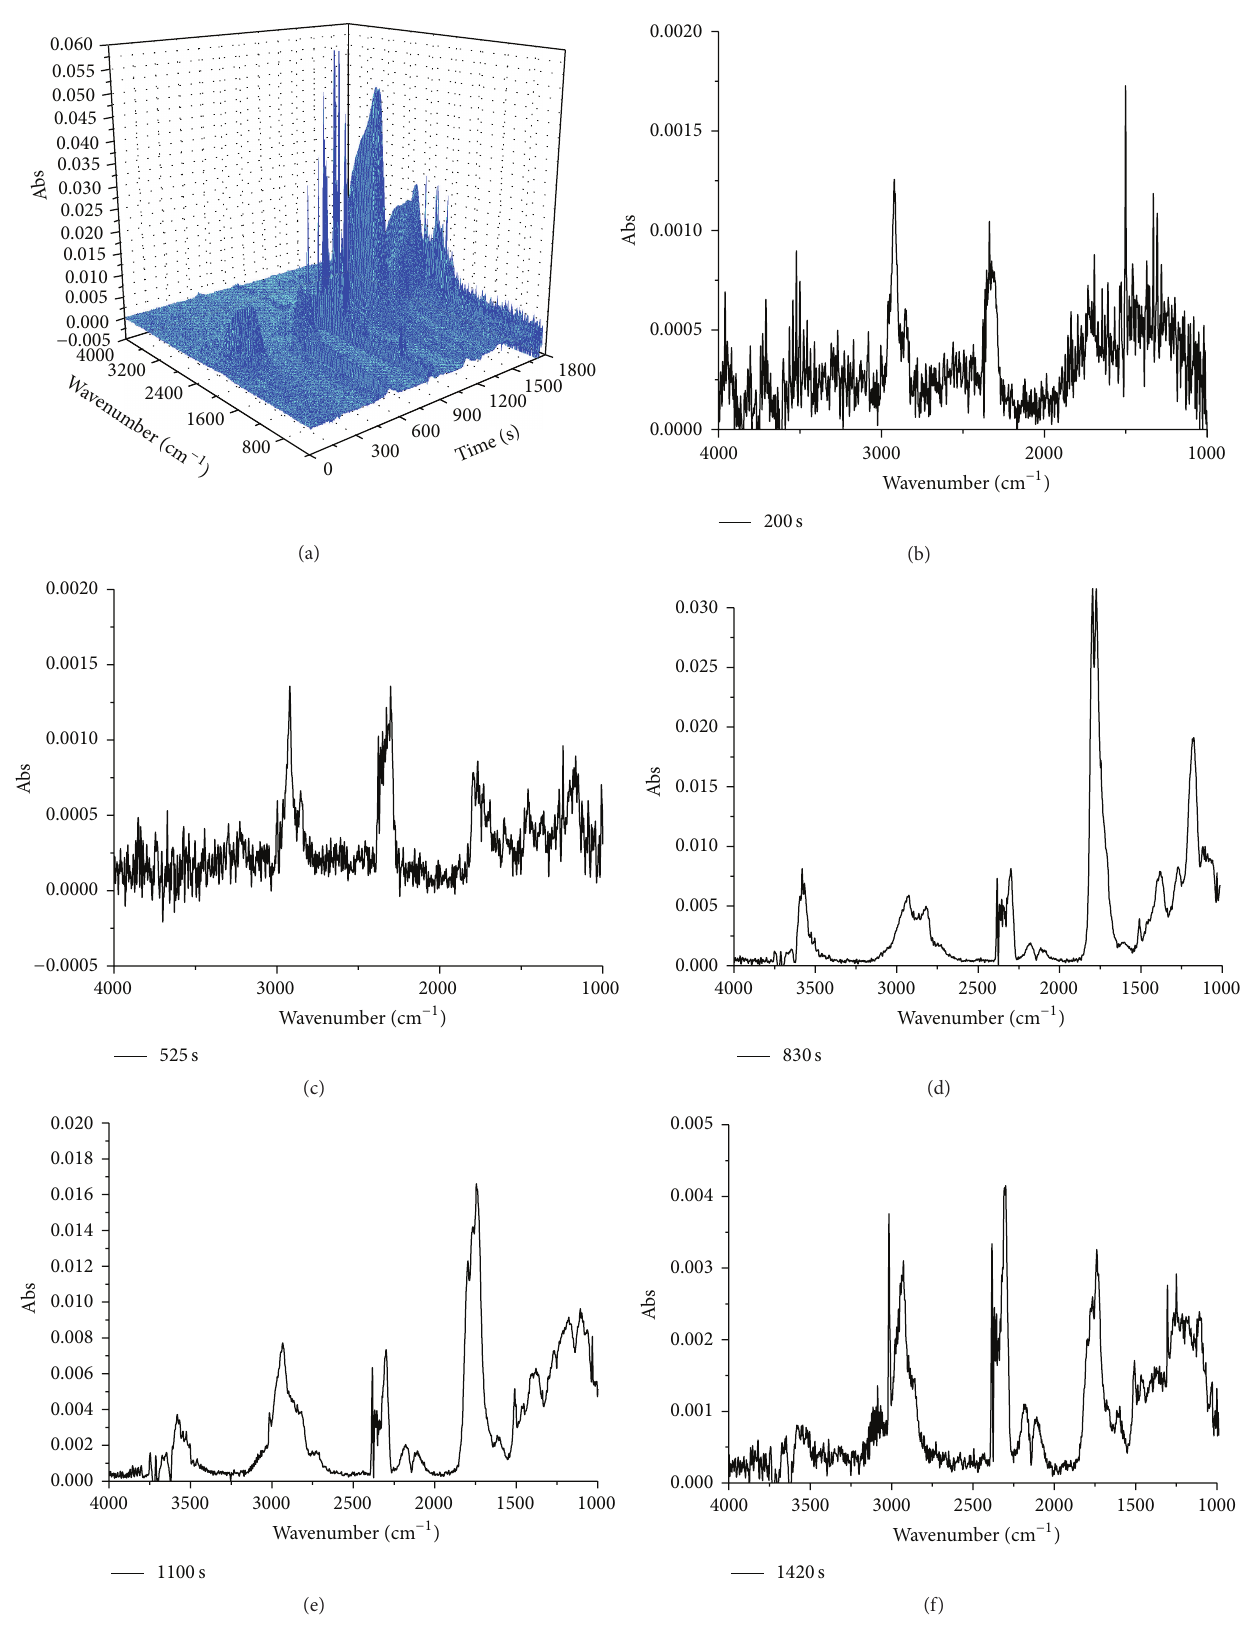
Figure 6: FTIR spectra of willow branches at different times. (a) Three-dimensional IR spectrum and IR spectra obtained at (b) 200 s, (c) 525 s, (d) 830 s, (e) 1100s, and (f)